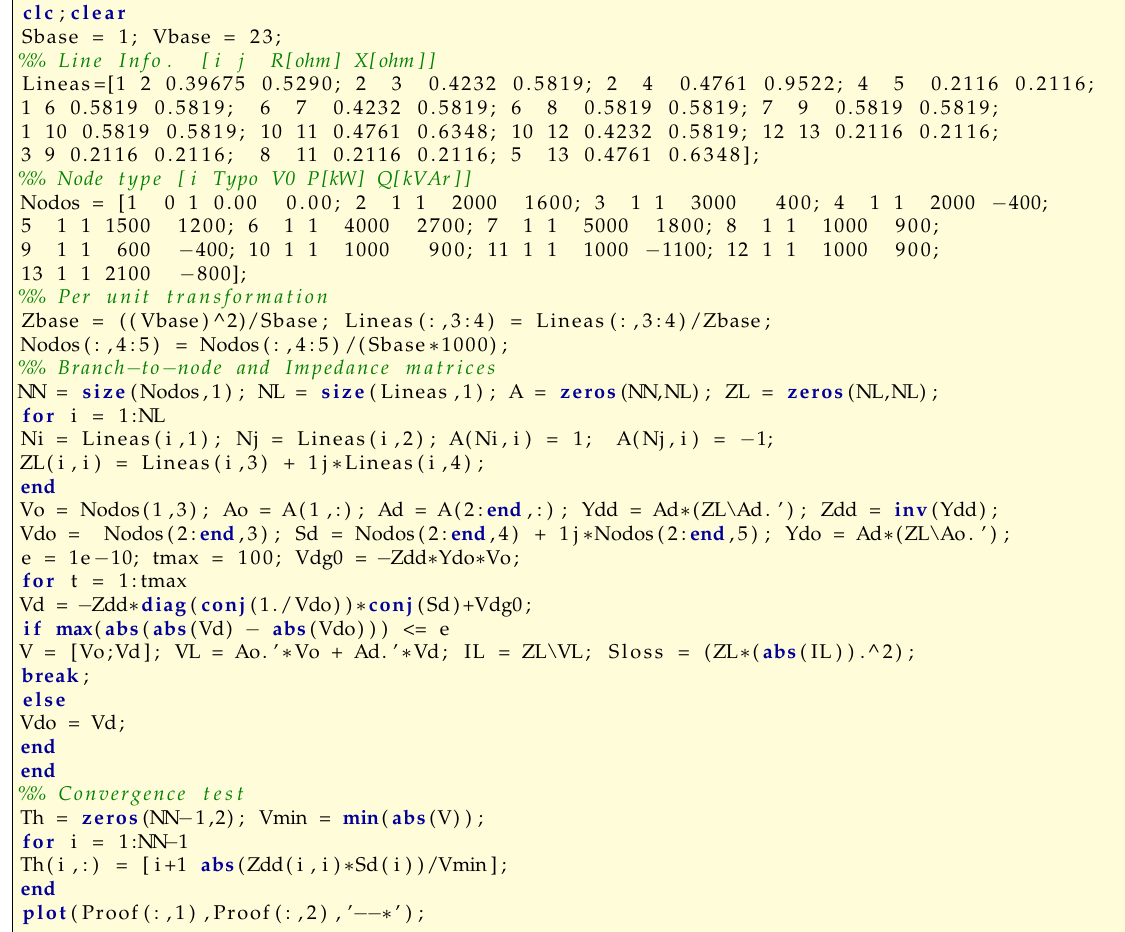
Figure 3. MATLAB implementation of the matricial iterative sweep power